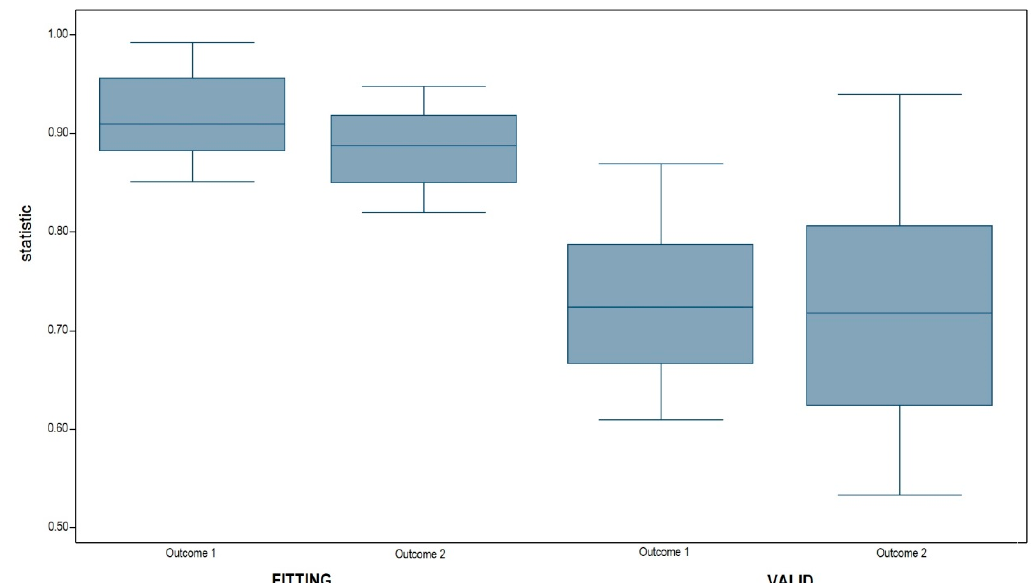
Figure 5. Discrimination of the models: fitting values versus validation distribution for the four MELR models. Distributions are represented as box-plots: the line splitting of each box in two represents the median value; the bottom and top edges of each box represent the lower and upper quartiles; the values at which the vertical lines stop are the upper and lower values of the data.